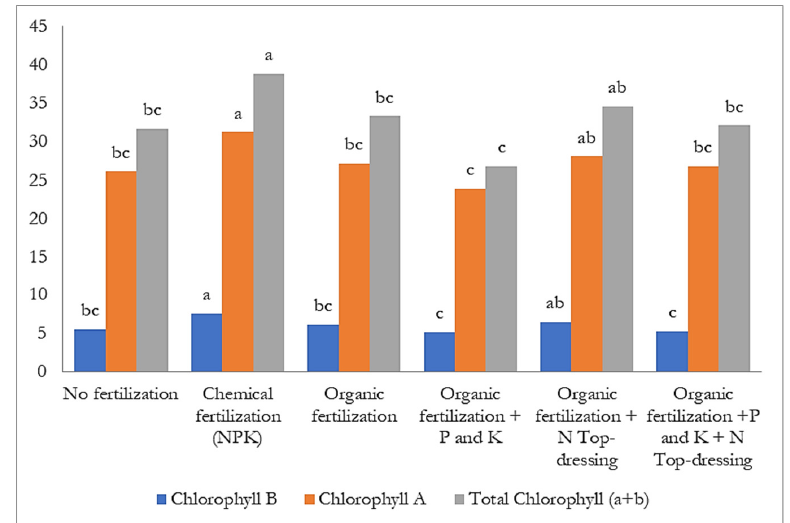
Figure 2. Falker Chlorophyll Index of the maize cv. ‘Potiguar’ under different fertilization management Means followed by the same letter in the series do not differ from each other by the Tukey test at 5%